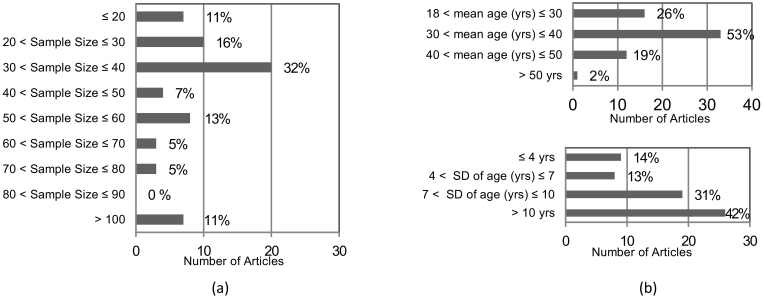
(a) Overall sample size, (b) participants mean age (top) and age variability expressed as standard deviation (SD) per number of selected articles. In brackets corresponding % of articles is shown.